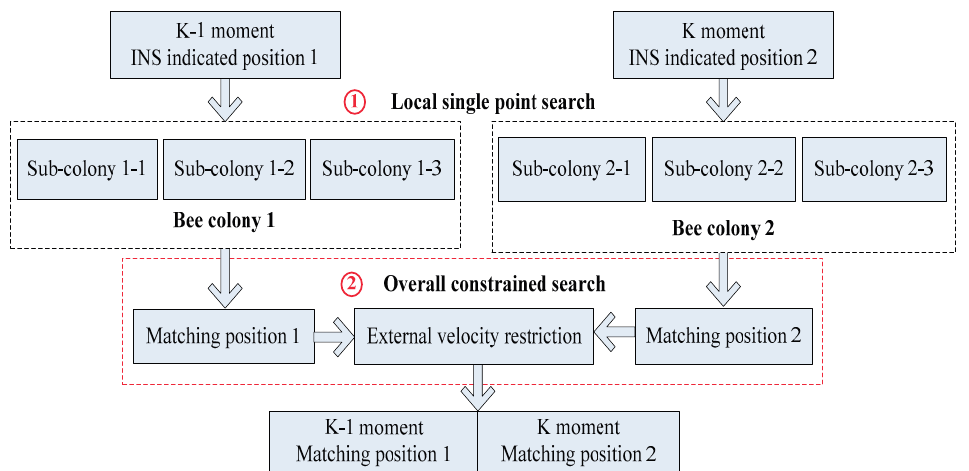
Figure 5. Flow chart of improved ABC